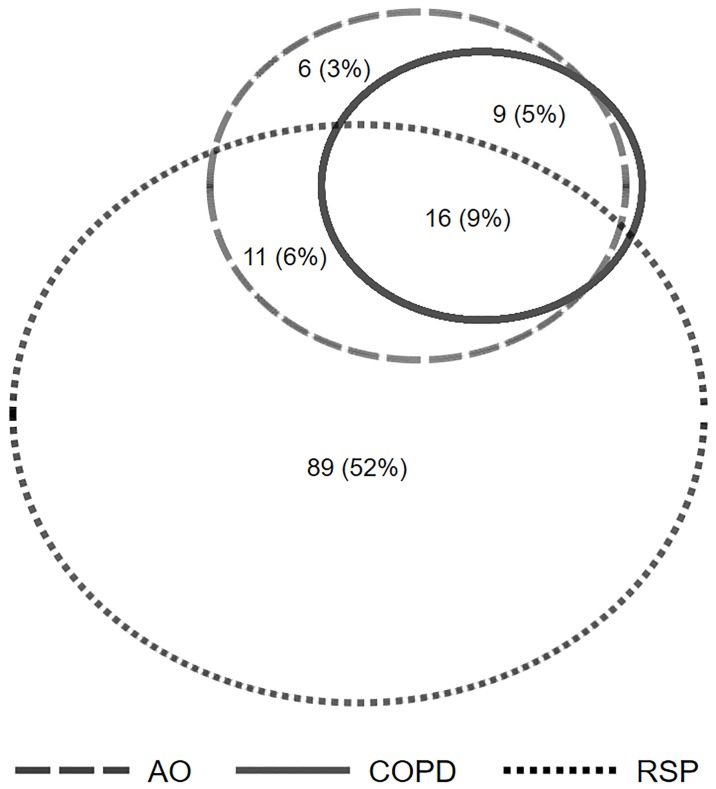
Burden of lung function defects among successfully treated TB cases.AO—airflow obstruction, COPD—chronic obstructive pulmonary disease, RSP—restrictive spirometry pattern. Burden of lung function defects calculated as a proportion of the total sample size (n = 172).